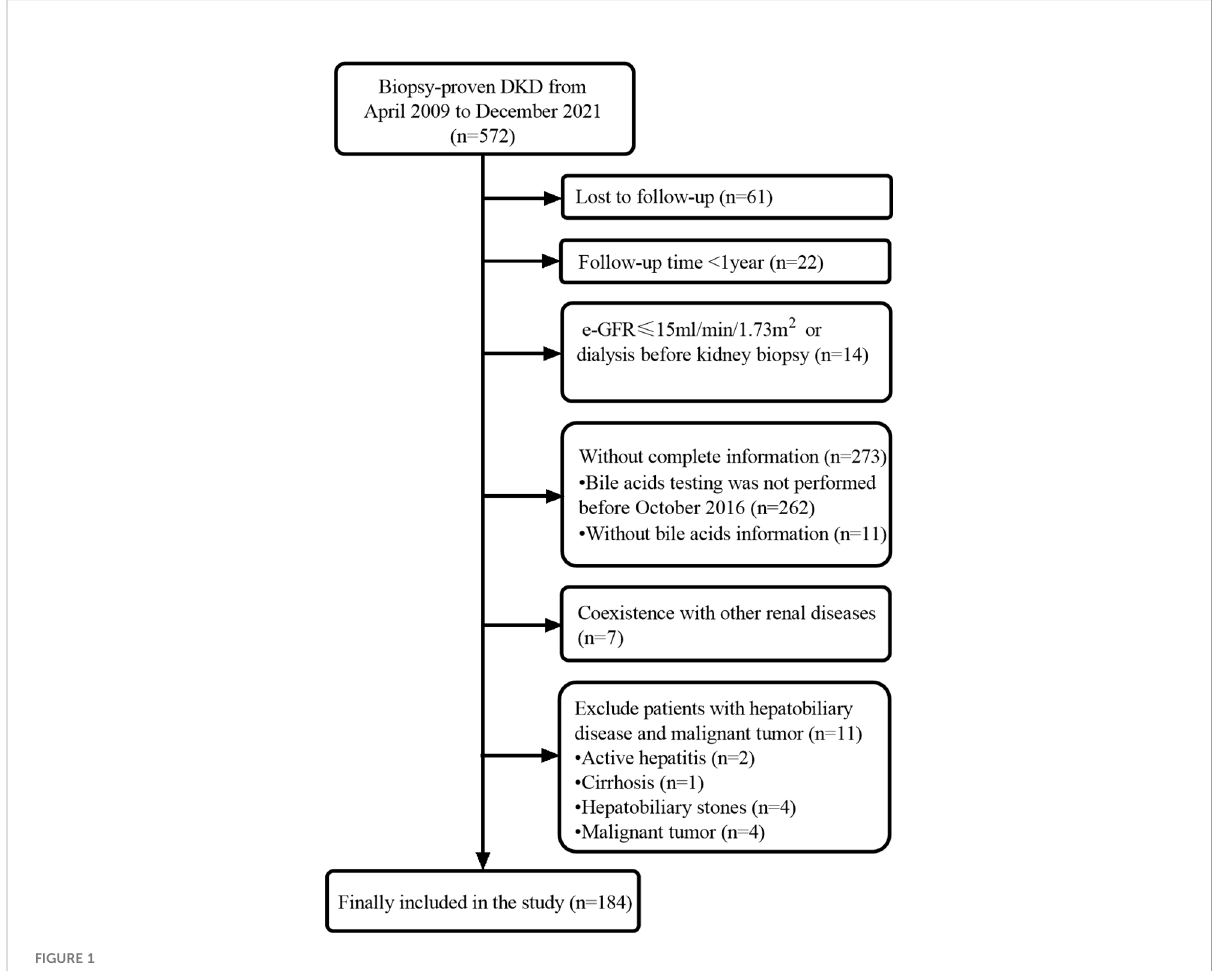
FIGURE 1 Flowchart of included patients in this